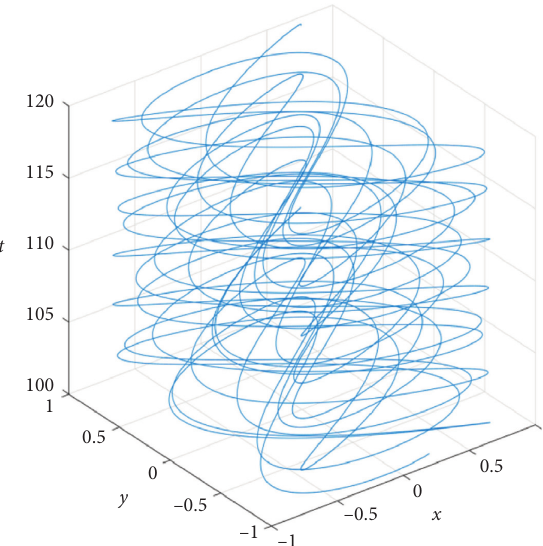
Figure 3: Quasiperiodic orbit of Lissajous type in x - y - t space for μ � 0 .